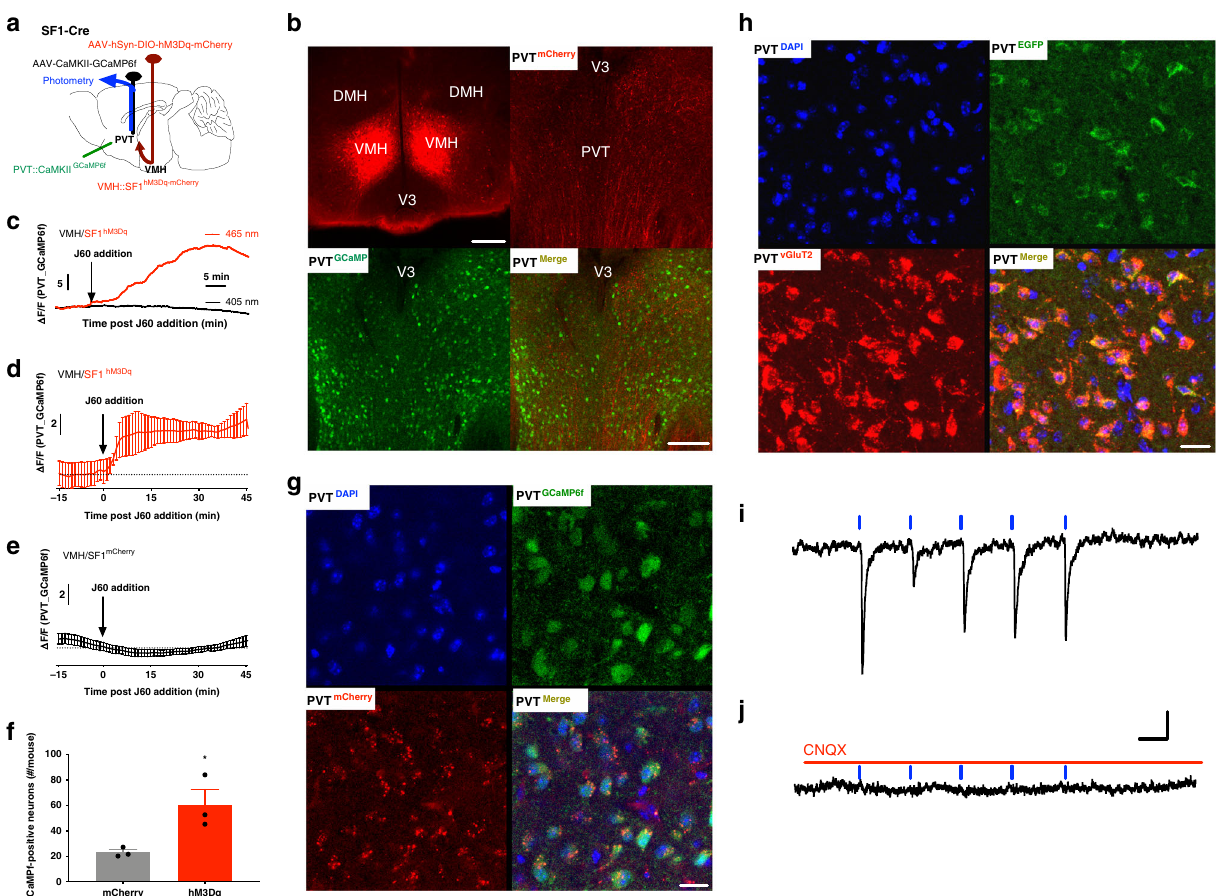
Fig. 4 VMH SF1 neurons project to PVT neurons. a Schematic depiction of photometry monitoring of PVT neurons in SF1-Cre mice transduced with hM3Dq in VMH SF1 neurons and PVT neurons with GCaMP 6f . b – g Acute PVT brain slice photometry experiments show that DREADD activation of SF1 neurons with J60 addition in the circulating ACSF potently increased PVT GCaMP 6f signals in the SF1 neuron hM3Dq-transduced mice ( n = 4) as compared to control mCherry-transduced mice ( n = 3): b representative images of hM3Dq-transduced SF1 neurons in VMH and GCaMP 6f -positive PVT neurons; c representative real-time monitoring of GCaMP 6f signals before and after J60 addition in an isolated PVT brain slice of hM3Dq-transduced animal; d average PVT GCaMP 6f signals from the SF1 neuron hM3Dq-transduced mice ( n = 11 sections/4 mice); e average PVT neural GCaMP 6f signals from the SF1 neuron mCherry-transduced mice ( n = 9 sections/3 mice); f group data of GCaMP 6f -positive neurons in the PVT ( n = 3 per group; p